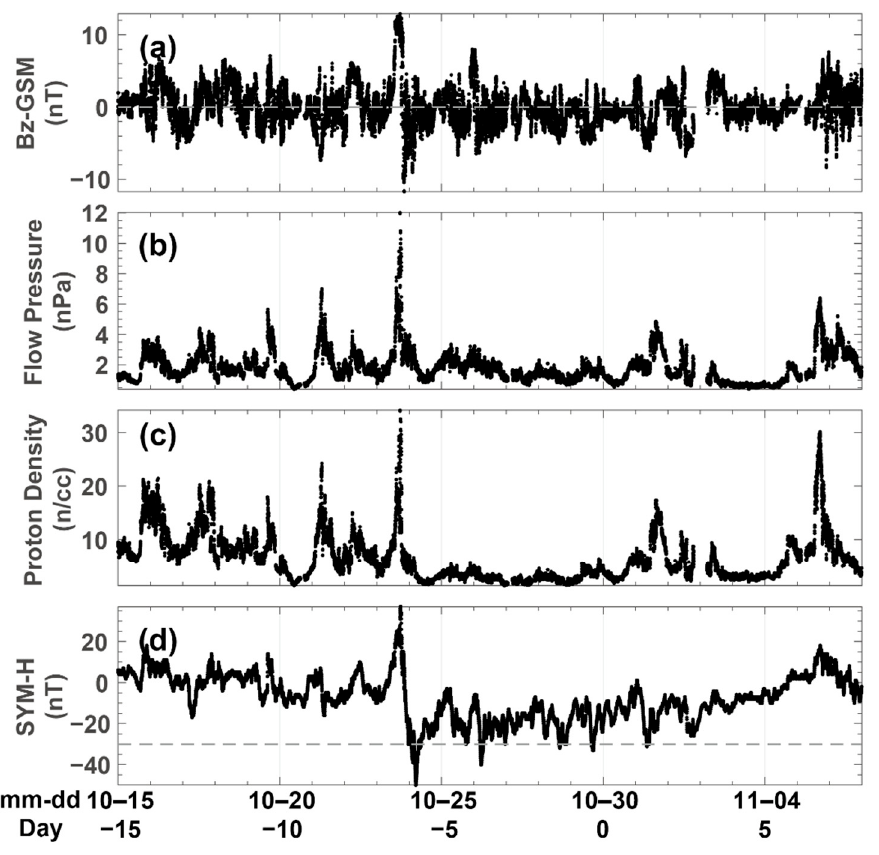
Figure 9. Solar wind parameters and SYM-H indices from 15 October to 6 November, i.e., 15 days before to 7 days after the M7.0 earthquake. ( a ) IMF Bz in GSM coordinates; ( b ) the solar wind dynamic pressure; ( c ) the solar wind proton density and ( d ) the SYM-H index. The dashed line indicates − 30 nT.